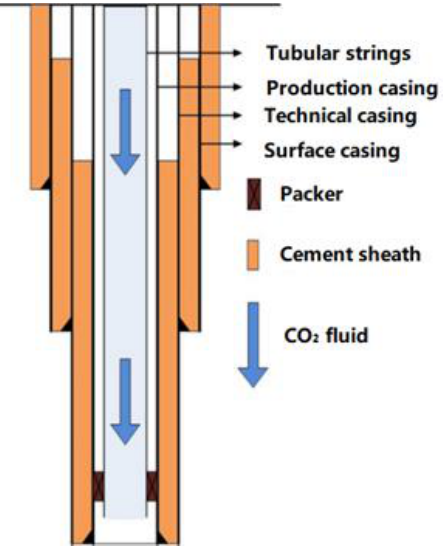
Figure 1. Physical model of CO 2 injection strings.